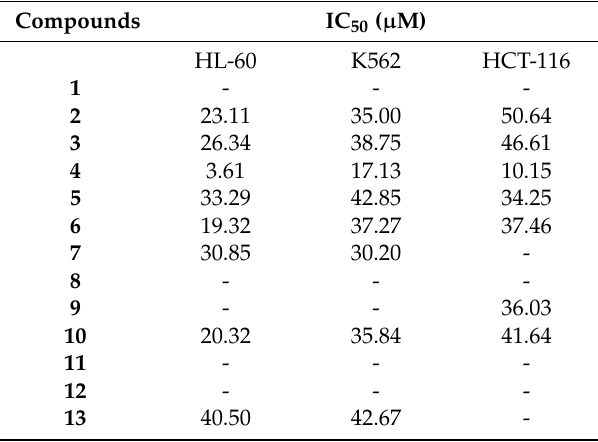
Table 3. IC 50 of Compounds 1 – 19 on three cancer cell lines.